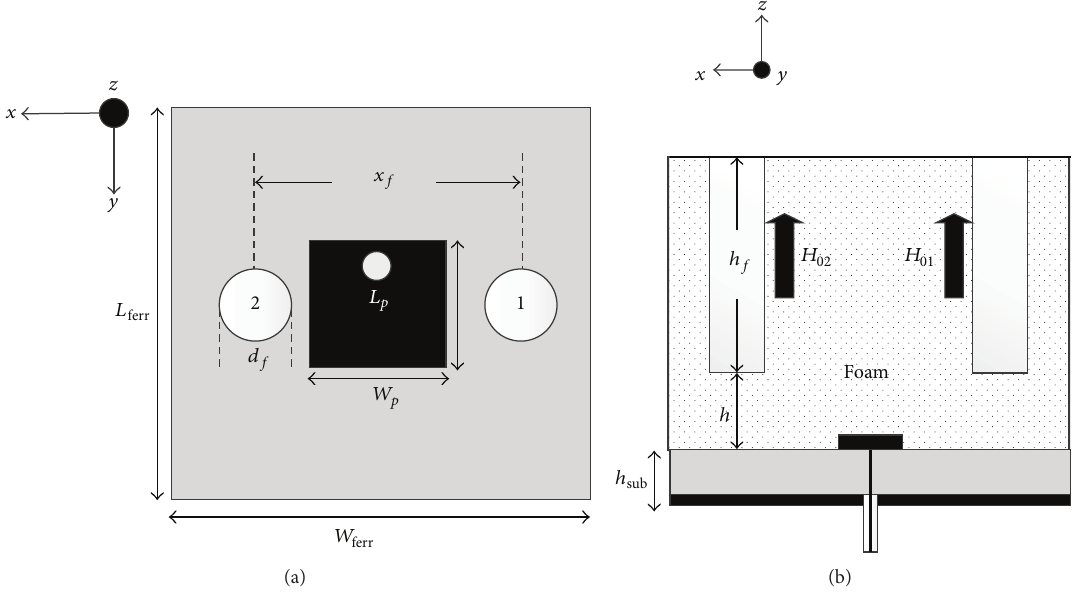
Figure 3: Magnetized ferrite loaded patch antenna: (a) top view and (b) side view.